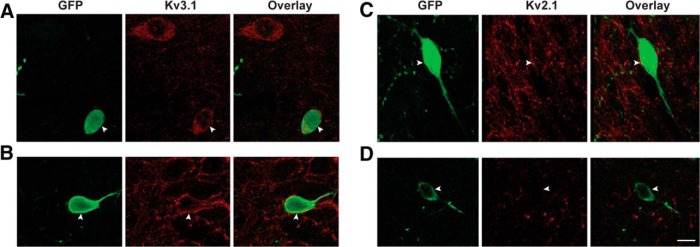
Kv3.1 and Kv2.1 expression in putative IS3 cells. A, B, Immunohistochemistry data showing GFP (green; left) and Kv3.1 expression (red; middle) in the stratum radiatum (A) and pyramidale (B) of a VIP-GFP mouse. Note the presence of Kv3.1 membrane labeling in the soma and proximal dendrites of VIP- expressing cells. C, D, Immunohistochemistry data showing GFP (green; left) and Kv2.1 expression (red; middle) in the stratum pyramidale (C) and radiatum (D) of a VIP-GFP mouse. Scale bar, 10 μm.